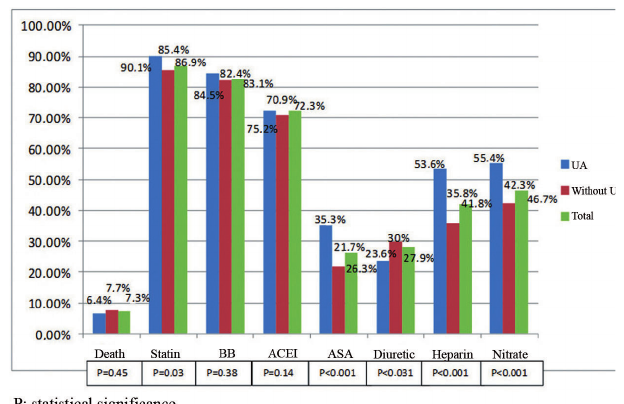
Fig. 2 - Rates of death, use of statins, beta-blockers (BB), angiotensin converting enzyme inhibitors (ACEI), acetylsalicylic acid (ASA), diuretic, Heparin (heparin) and nitrate in patients with unstable angina (UA) and without preoperative surgical myocardial revascularization. Analysis of the period 2004 - 2010, total of 1019 patients